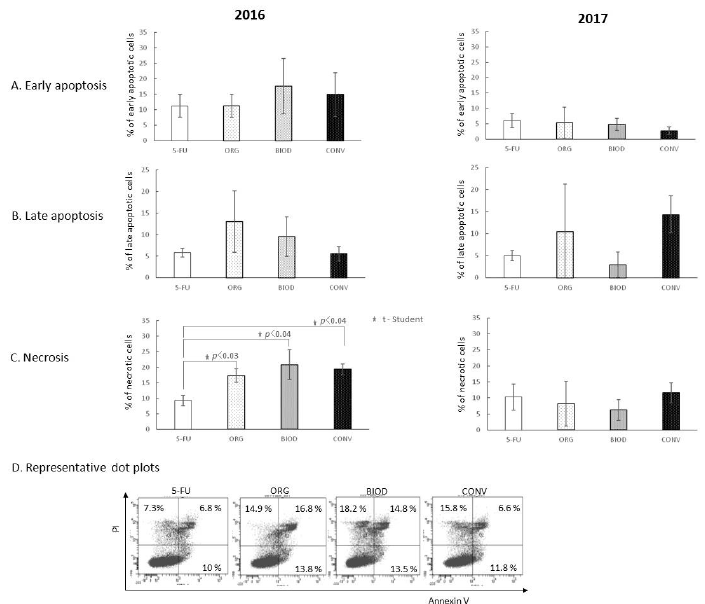
Figure 4. Interference of blueberry extracts on the apoptosis and necrosis-inducing activity of 5-FU. ( A ) Effect of blueberry extracts on the induction of apoptosis by 5-FU at the early phase; ( B ) effect of blueberry extracts on the induction of apoptosis by 5-FU at the late phase; ( C ) effect of blueberry extracts on the necrosis-inducing potential of 5-FU; ( D ) representative dot plots for AnnexinV/FITC and PI staining for 2016. The 5-FU—HT-29 cell culture with 5-FU alone; ORG, BIOD, CONV—HT-29 cell culture with blueberry extracts from particular types of production system (ORG—organic, BIOD—biodynamic, CONV—conventional) and 5-FU.